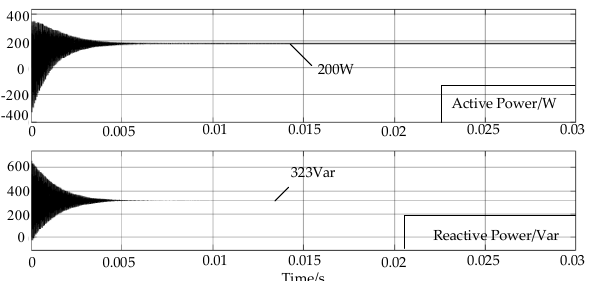
Figure 32. ϕ AD = 92.29 ◦ and ϕ AB = 185 ◦ active power and reactive power waveforms.